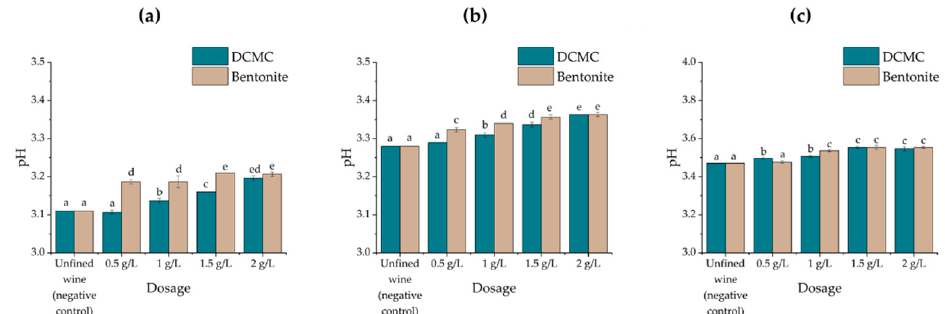
Figure 5. Changes in the wine pH after treatment with increasing amounts of bentonite or DCMC. Different letters represent statistically significative differences among different homogeneous subsets for p = 0.05. ( a ) Encruzado, ( b ) Viosinho, and ( c ) Moscatel de Setúbal monovarietal wines.